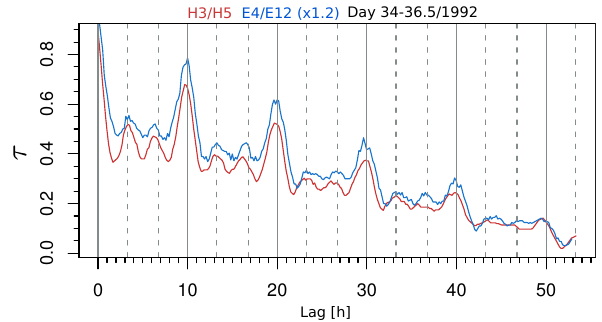
Fig. 5. Result of the ordinal autocorrelation analysis of the H3/H5 (red) and E4/E12 (blue) ratios for days 34–36. Similar to Fig. 4, this figure not only reflects the temporal variation related to the clock mechanism, but also shows evidence of a second periodic modulation related to the minor peaks in the spectral index. The shift between both variations is ∼ 3 . 25 h. Fig. 6. Local rank structure of the HET H3/H5 ratio from day 34 to 38.5. The time series starts at rotation 1 (bottom) and ends with rotation 12 (top). The colour code must be interpreted in a way that red squares indicate that the actual data point has a higher rank than its predecessor 10, while green indicates a lower rank (i.e. the local maxima of the H3/H5 ratio occur when the colour switched from red to green). As expected, this is the case for longitudes of about 270 ◦ , reflecting the major peaks of the Jovian clock. Furthermore, the minor peaks are clearly present with local maxima at 40–100 ◦ .